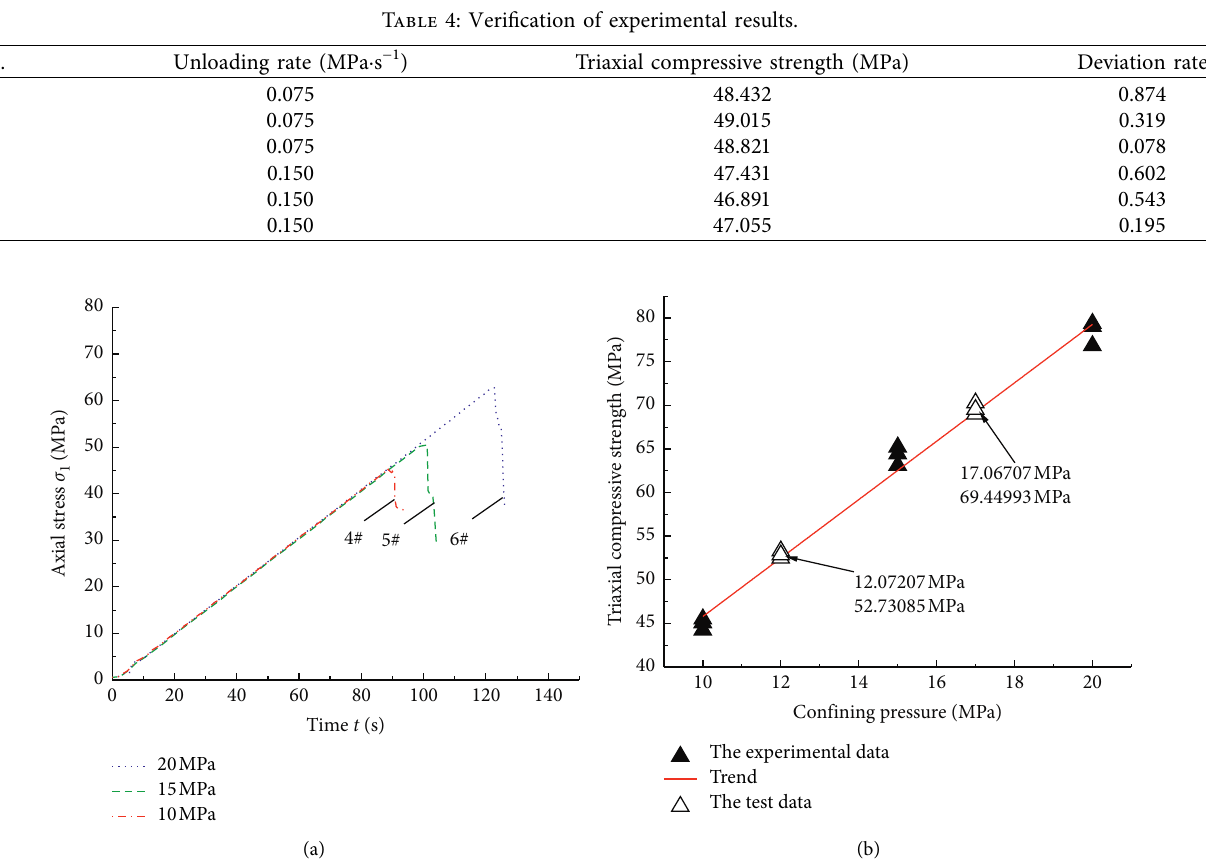
Figure 4: Stress path and compressive strength under different confining pressures. (a) Stress path of 4# ∼ 6#. (b) Triaxial compressive strength fitting